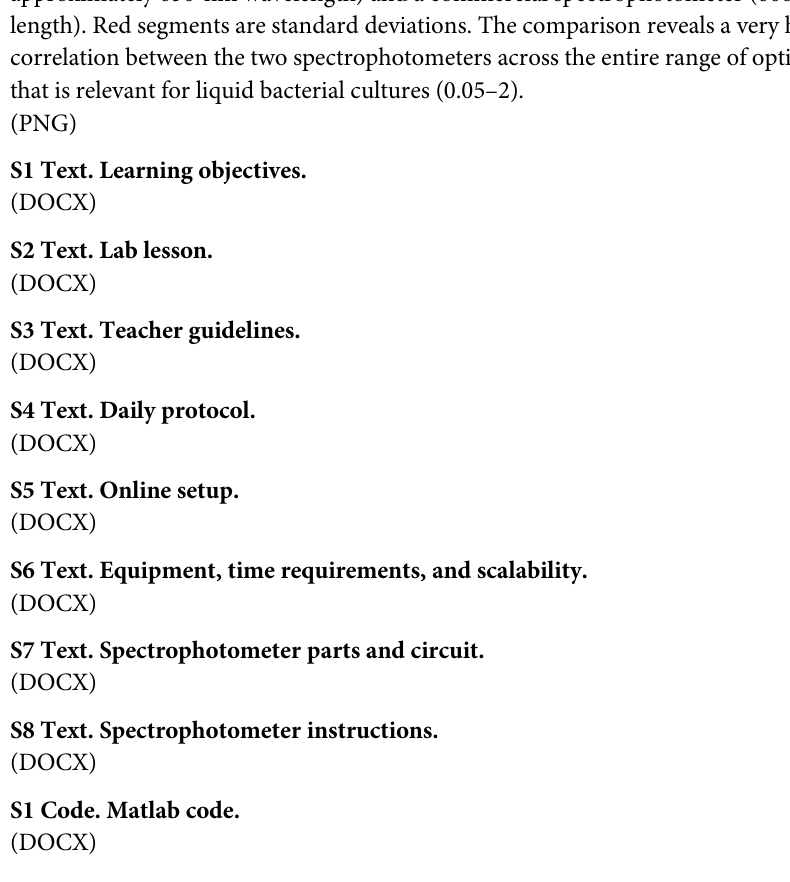
S2 Fig. Comparison between students’ and teachers’ questionnaires. (A) Students ( N = 67) and teachers ( N = 6) reporting on students’ cognitive and behavioral engagement. Bars mark mean score, and black segments mark the standard deviation (discrepancies between teachers and students were not statistically significant in a Kruskal-Wallis Test). (B) Students ( N = 42– 69) and teachers ( N = 6) reporting on the value of different teaching and communication tech- nologies. Bars mark mean score, and black segments mark the standard deviation (discrepan- cies between teachers and students were not statistically significant). (C) Teachers’ self- reported evaluation ( N = 6) of their students’ achievements and project involvement. Each teacher was requested to evaluate the percentage of students that the different statements apply to (as compared to a standard curriculum taught over the years). The size of the pie slices indi- cates how many of the teachers had similar evaluations of their respective students. S3 Fig. The developed low-cost spectrophotometer. (A) We used an Arduino microcontrol- ler and standard electrical components to build a circuit that can measure optical density in standard 2-ml tubes. The circuit was housed in small laser-cut acrylic box and 3D-printed plas- tic holder. The unit cost was less than $15 to fabricate. (B) A comparison between optical den- sity measurements made by our low-cost spectrophotometer (using a red-light source, approximately 650-nm wavelength) and a commercial spectrophotometer (600-nm wave- length). Red segments are standard deviations. The comparison reveals a very high degree of correlation between the two spectrophotometers across the entire range of optical densities that is relevant for liquid bacterial cultures